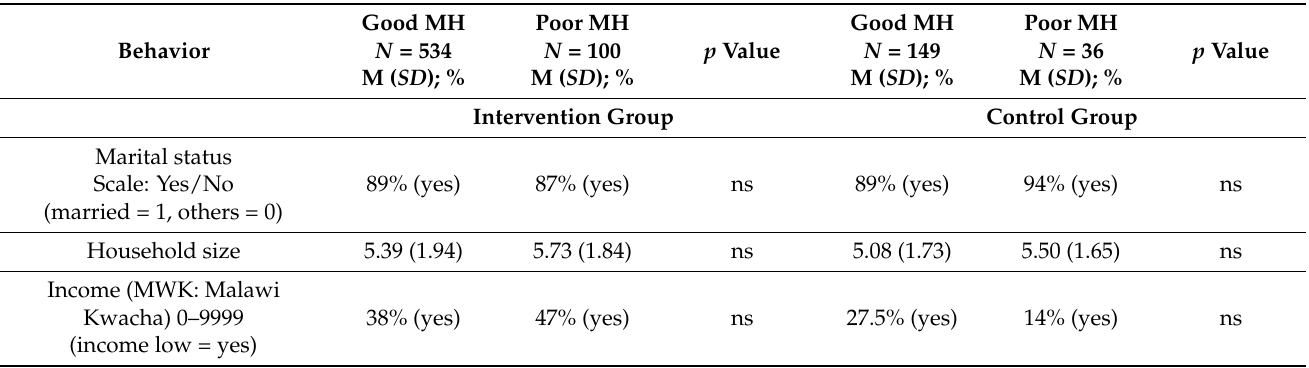
Table 2. Mean comparison of contextual factors of the study participants on mental health condition: poor versus good; t -test,